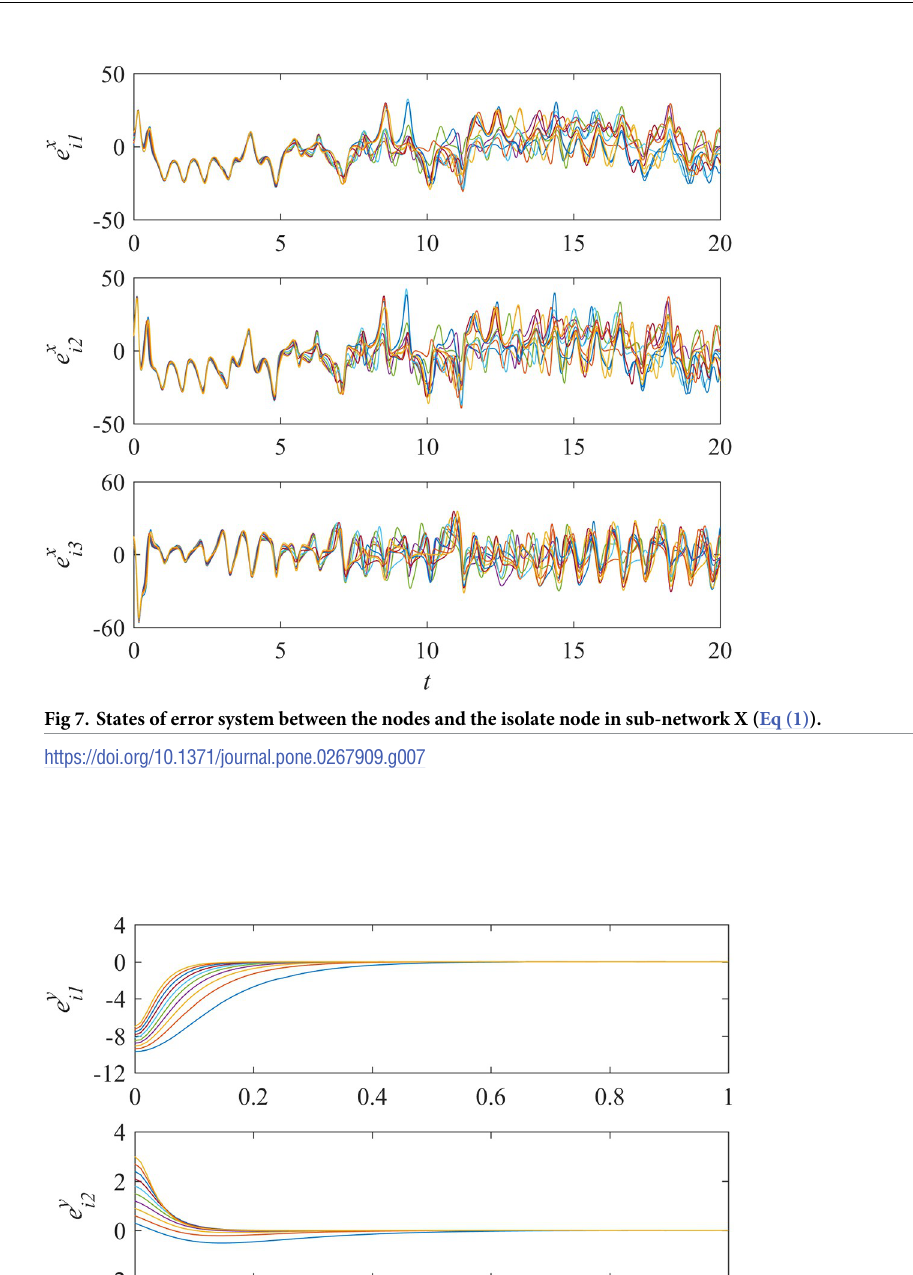
PLOS ONE | https://doi.org/10.1371/journal.pone.0267909 May 5,